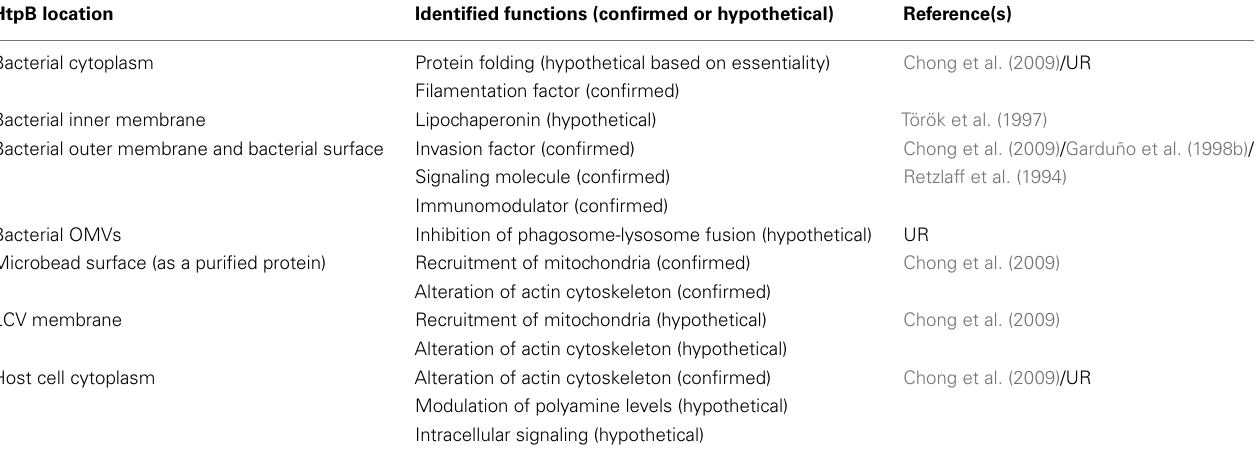
Table 1 | Identified functions of the L. pneumophila chaperonin, HtpB, according to its location in the bacterial cell and in the host cell. HtpB